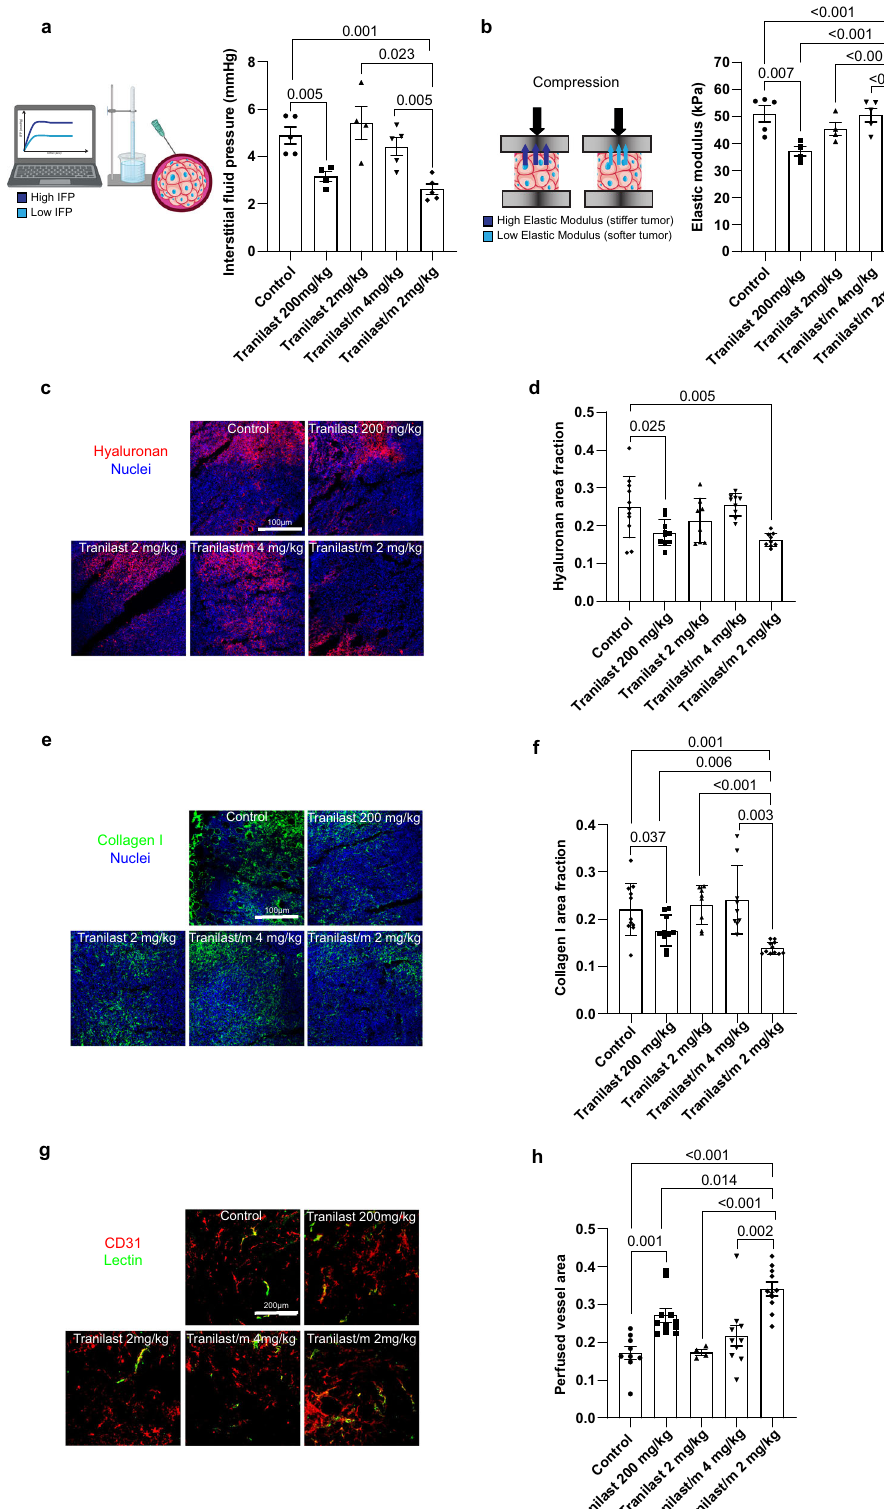
geneic, orthotopic triple-negative breast tumors were treated either withfreetranilastortheTranilast/m.Freetranilastwasadministeredat the optimal dose of 200mg/kg orally every day 18,25 or by intravenous injection (i.v.) at the dose of 2 mg/kg daily. Tranilast/m were